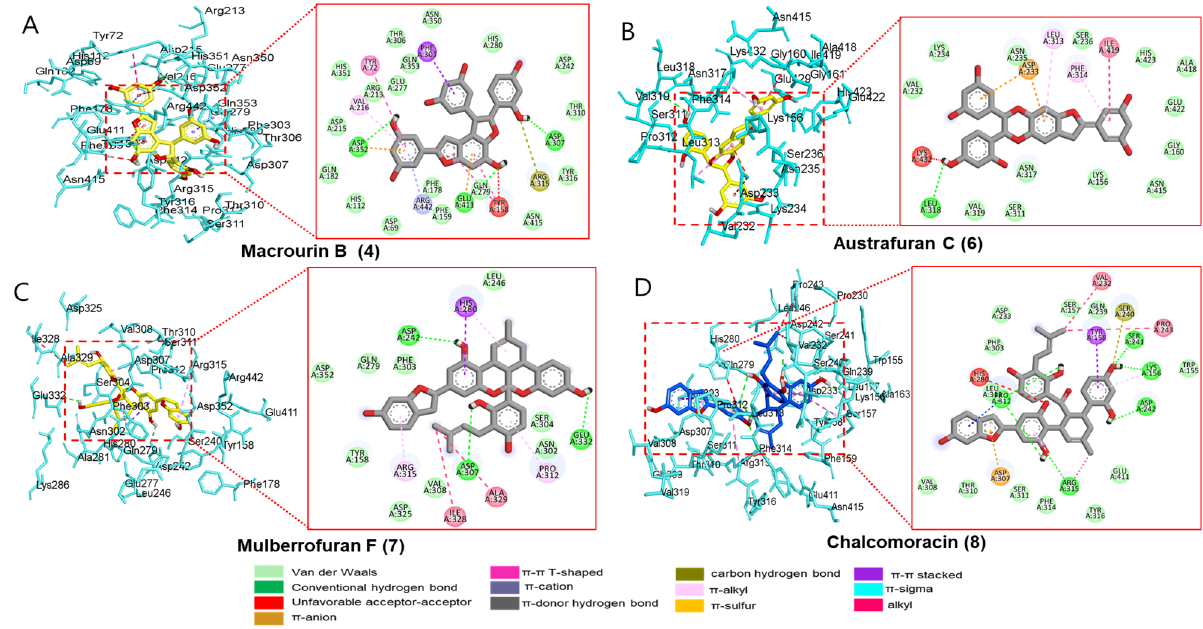
Figure 5. Molecular docking simulation models for α -glucosidase inhibition at the catalytic site by macrourin B ( A ), austrafuran C ( B ), mulberrofuran F ( C ), and chalcomoracin ( D ). 3D ( left ) and 2D ( right ) docking simulations were shown at each compound. Interaction was differentiated by various color (bo tt om). Table 5. Binding site residues and docking scores of compounds in the α -glucosidase using the Au- toDock Vina 4.2 program.